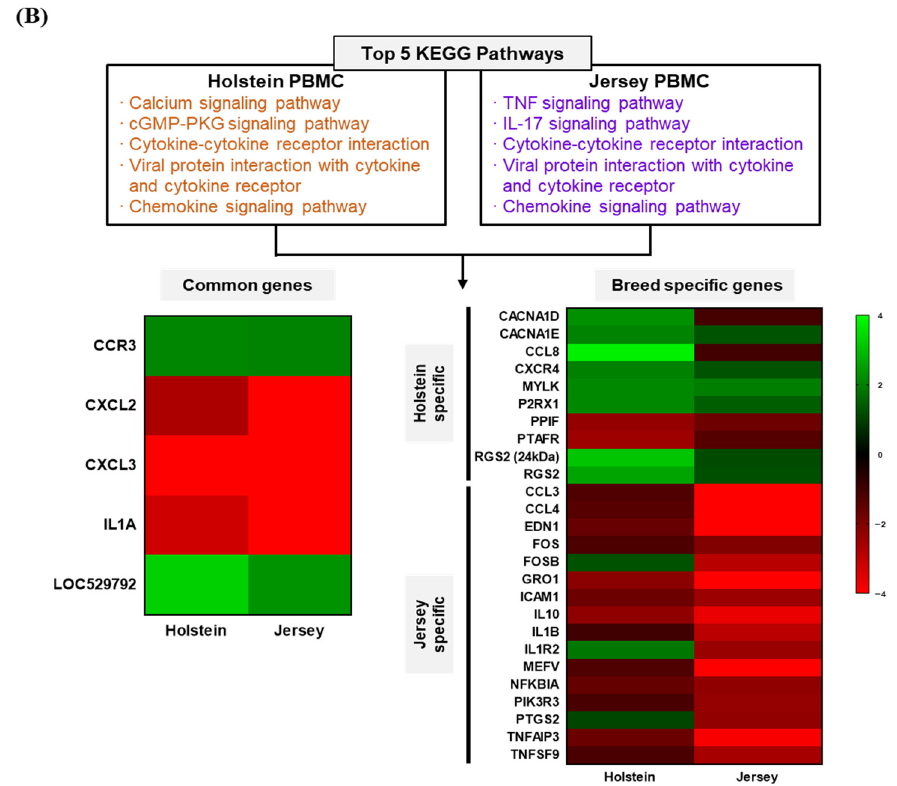
Figure 6. Summary of transcriptome analysis of PBMCs for two breeds of dairy cow in different THI conditions. Numbers of DEGs in Holstein and Jersey PBMCs in MT and HT condition ( A ). Heatmap represents a list of top five KEGG pathways and common and breed-specific DEGs-based genes associated with cut-off KEGG pathways ( B ).